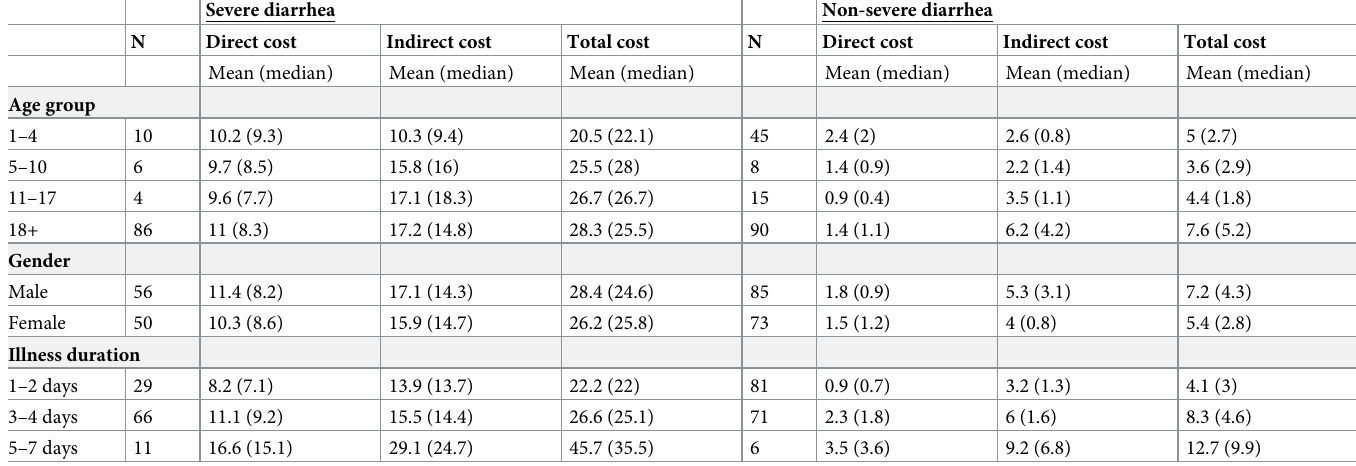
Table 4. Average household cost of severe and non-severe diarrhea by age, gender and duration of illness of Tongi Township in Dhaka, Bangladesh from September 2015 to June 2016,